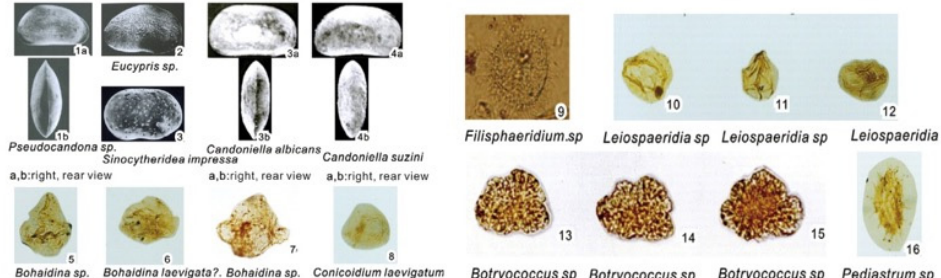
Figure 7. Neogene shallow lacustrine paleontological assemblages in the PL Oilfield [29] .